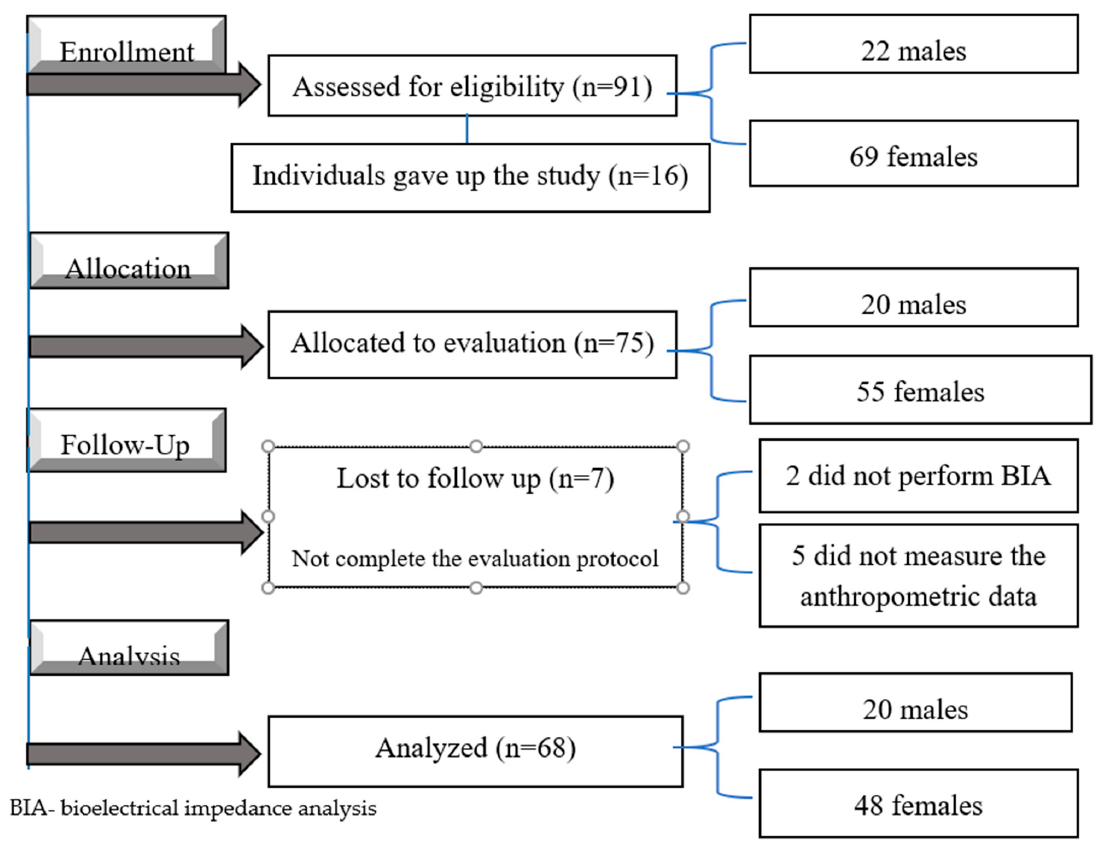
Figure 2. Flow diagram according to the STrengthening the Reporting of OBservational studies in Epidemiology (STROBE) criteria.